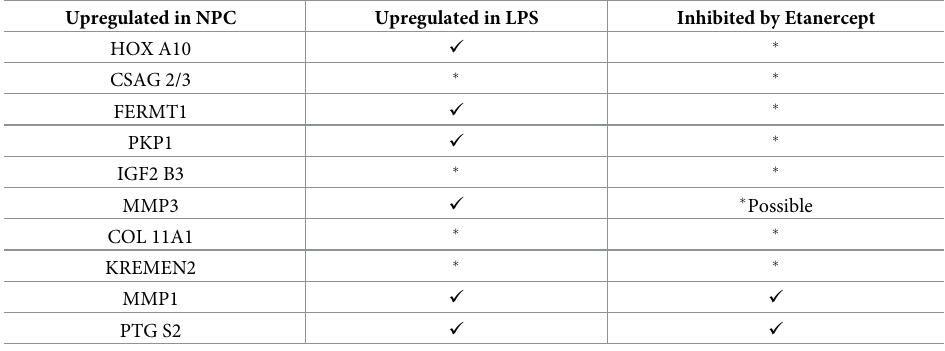
Table 2. IPA analysis table of upregulated genes both in LPS-induced damage, NPC and inhibited by etanercept. Upregulated in NPC Upregulated in LPS Inhibited by Etanercept HOX A10 ✓